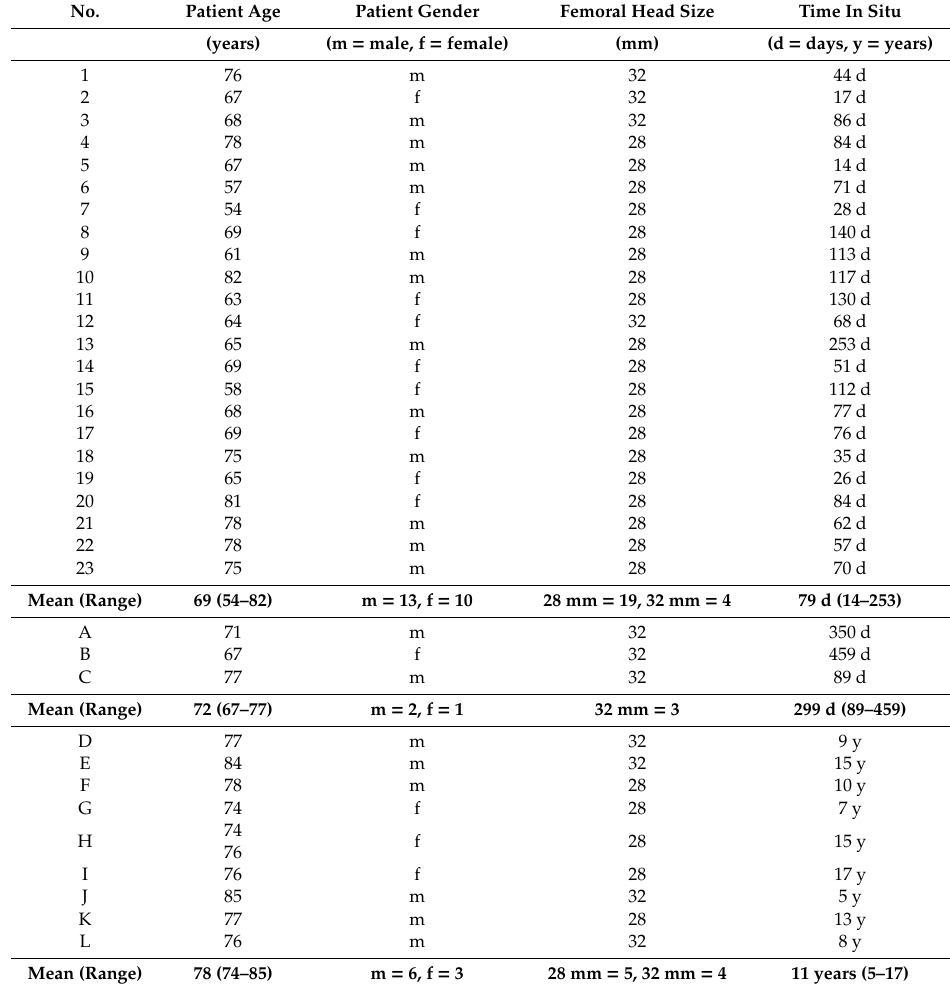
Table 1. Clinical data of the 3 groups: articulating spacer patients (No. 1–23), conventional hip arthroplasty patients with short implant time in situ (No. A–C), and long time in situ (No.